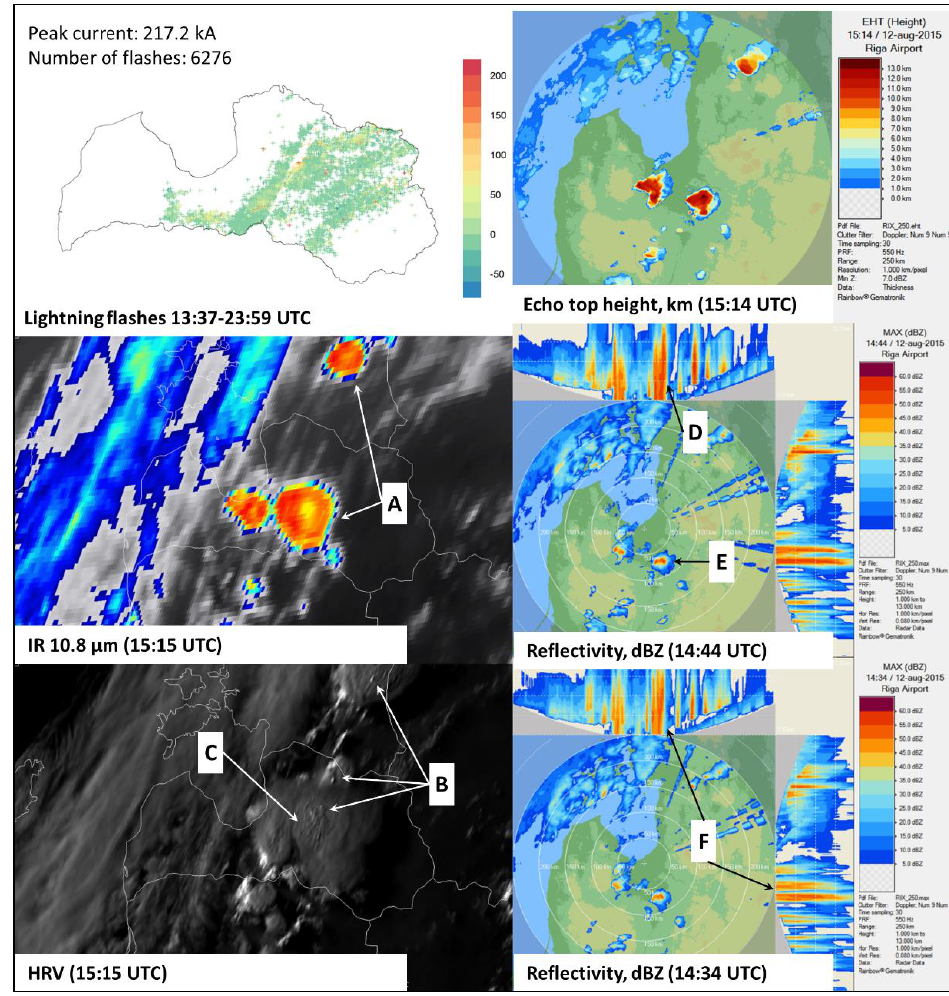
Fig. 1. Example of the thunderstorm features identified for a severe convective storm observed in Latvia on the 12 th August 2015. The identified features are marked with letters A–F as follows: A – cold-ring structures; B – overshooting tops; C – gravity waves; D – tilted updraft; E – hook echo; F – weak echo